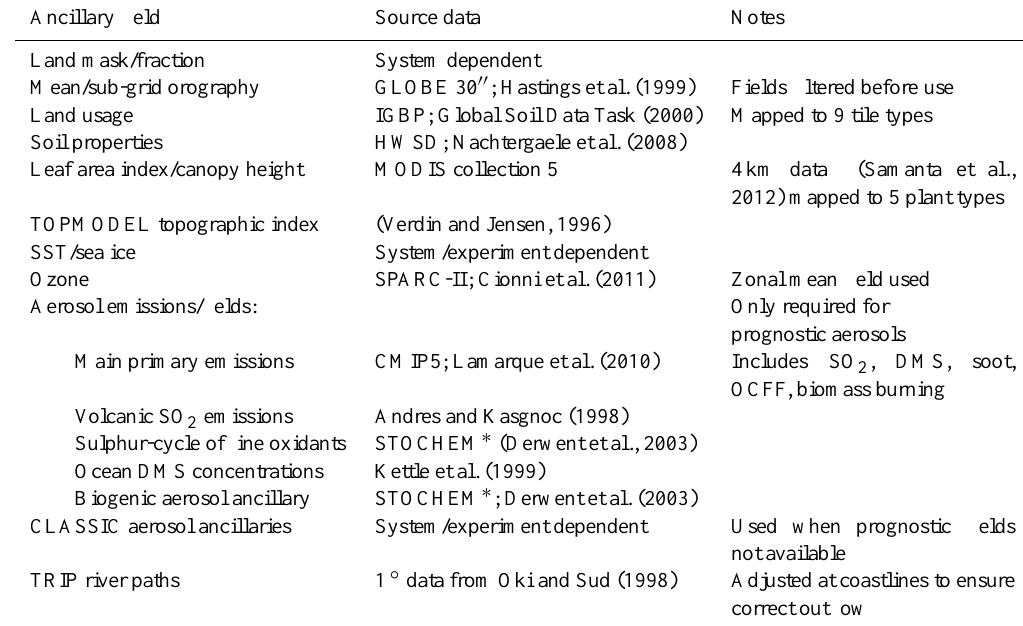
Table 1. Source data sets used to create standard ancillary files used in